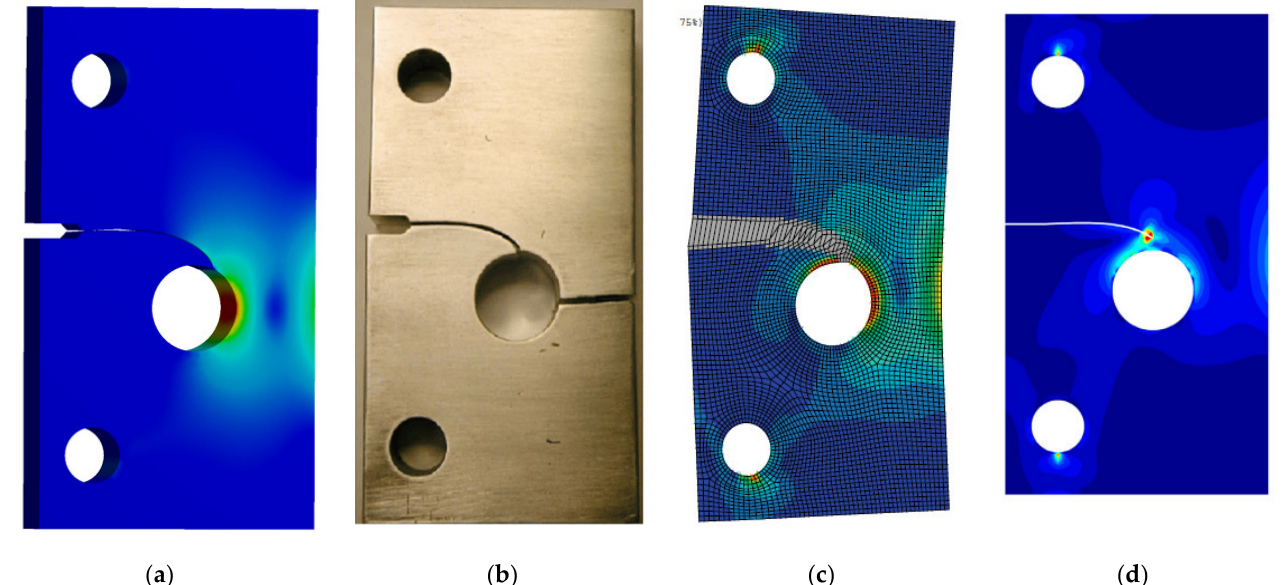
Figure 11. Comparison of crack growth trajectory; ( a ) present study; ( b ) experimental observation reproduced from [28] with permission from Elsevier 2009; ( c ) numerical reproduced from [28] with permission from Elsevier 2009; ( d ) numerical reproduced from [29] with permission from Elsevier 2018.